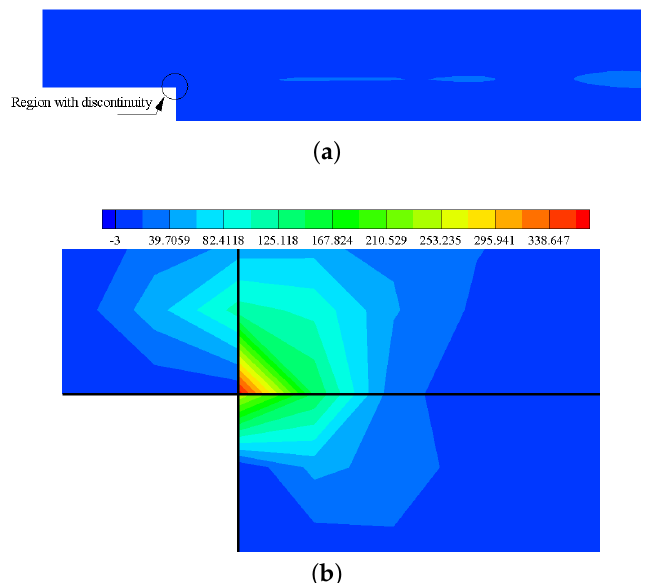
Figure 14. Contours of normalised mean turbulent kinematic viscosity ( ν t / ν ∞ ) for a 2D backward-facing step using a standard block interface treatment and illustrating the unnatural discontinuity introduced by the three-block interface. Note that ν ∞ is the freestream reference value of kinematic viscosity (1.46 × 10 − 5 ). ( a ) Full domain view; ( b ) Detail at the block interface (zoomed-in